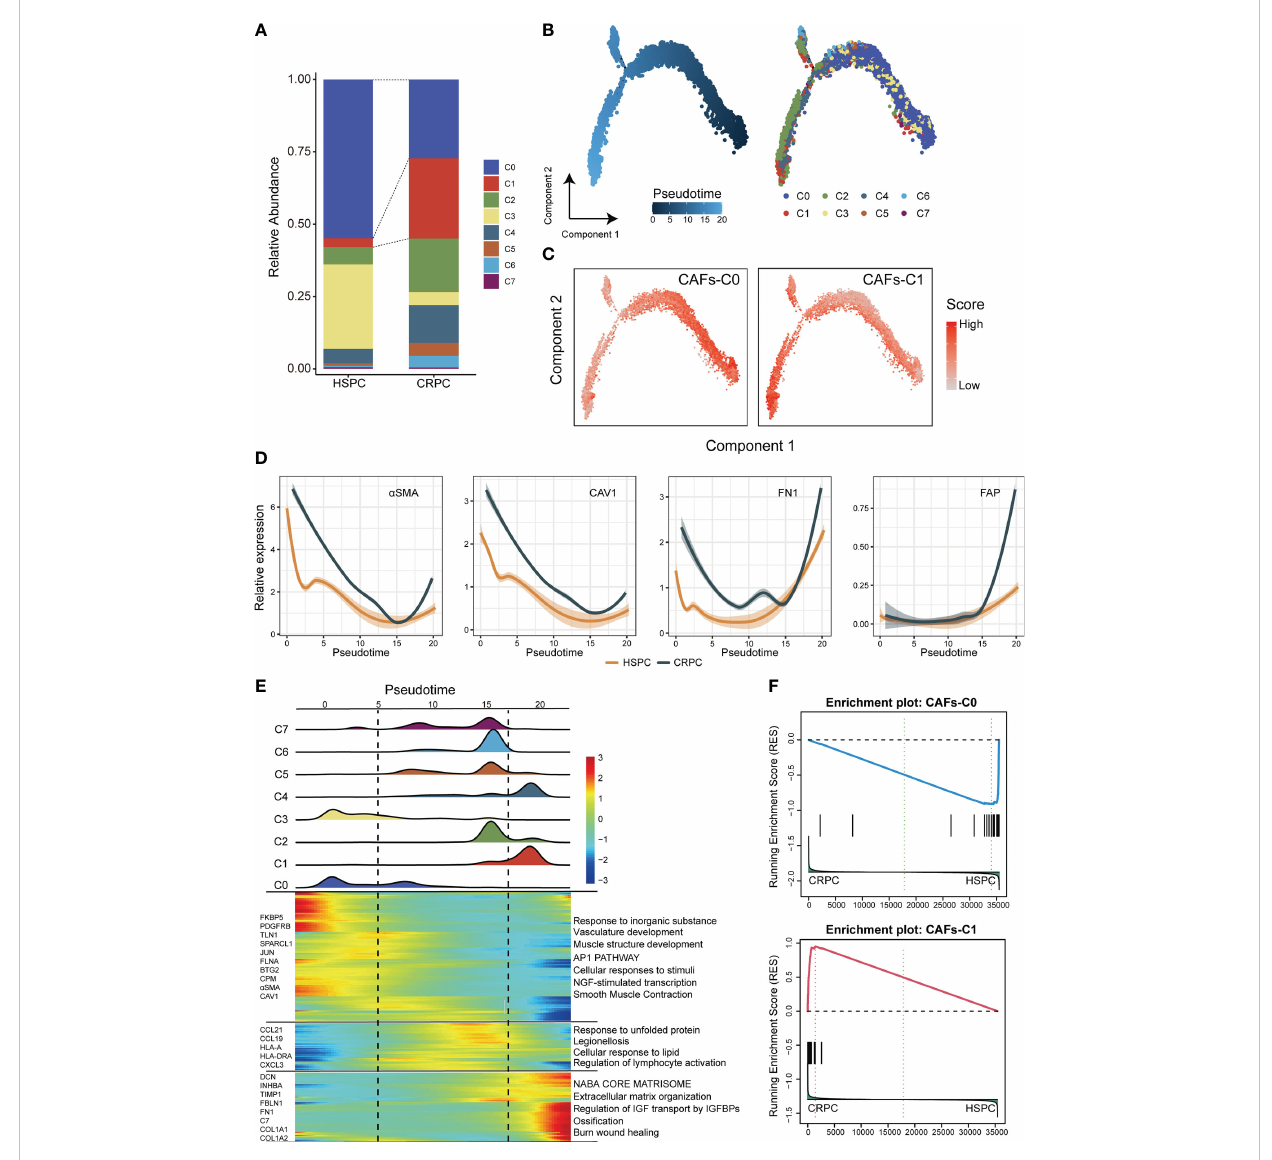
FIGURE 2 Compositional and transcriptional pro fi le changes associated with CAFs subtypes. (A) Relative abundance of each CAFs subtype in HSPC and CRPC samples. (B) Trajectory analysis of CAFs inferred by Monocle2. (C) The dynamics of CAFs-C0 and CAFs-C1 signature scores along the pseudotime. (D) The dynamic expression of CAFs-C0 marker genes ( a SMA and CAV1) and CAFs-C1 marker genes (FN1 and FAP) along the pseudotime. (E) Bottom. heatmap displaying the dynamics in gene expression along the pseudotime. Top. the distribution of CAFs subtypes along the pseudo- time. (F) GSEA analysis for CAFs-C0 and CAFs-C1 signature between HSPC-derived versus CRPC-derived